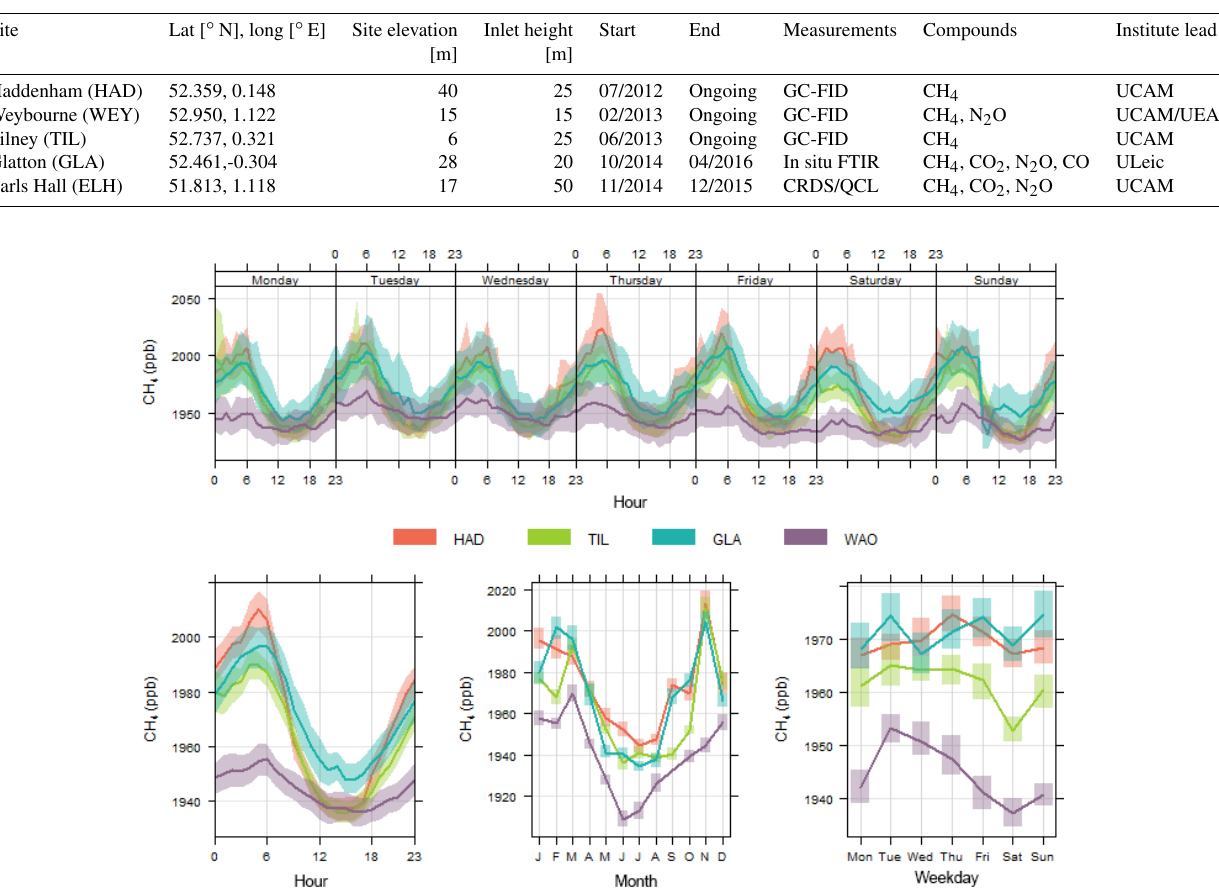
Table 4. Details of the measurements made in the GAUGE East Anglian network.